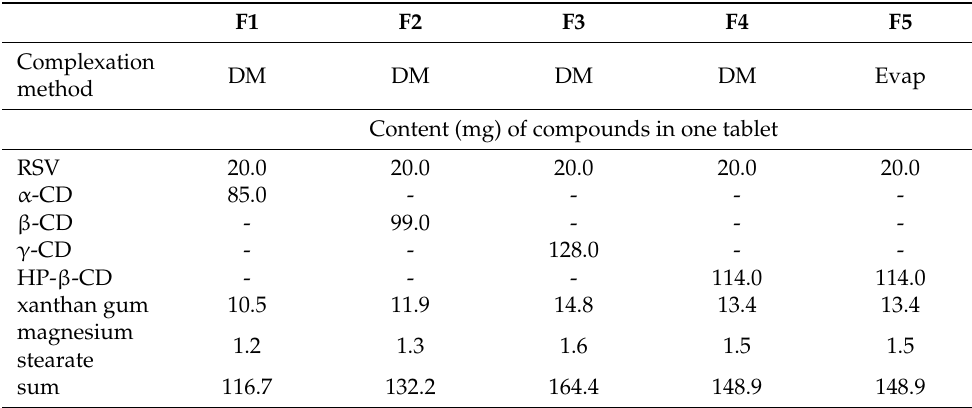
Table 1. The composition of tablet